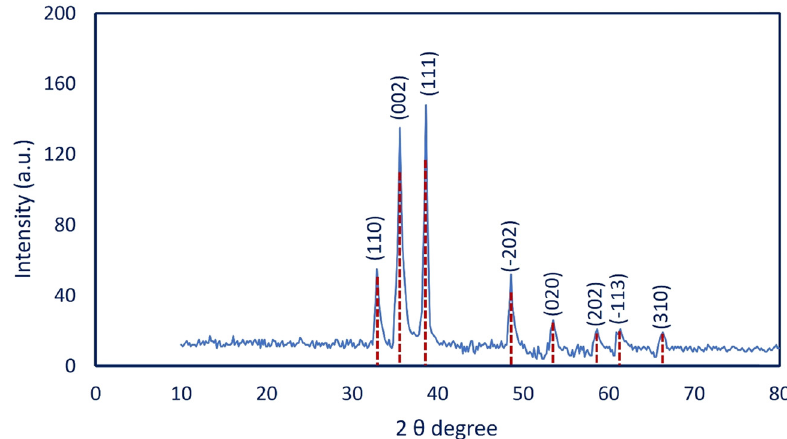
Figure 3: XRD pattern of CuO - NPs synthesized by endophytic bacterial strain B.